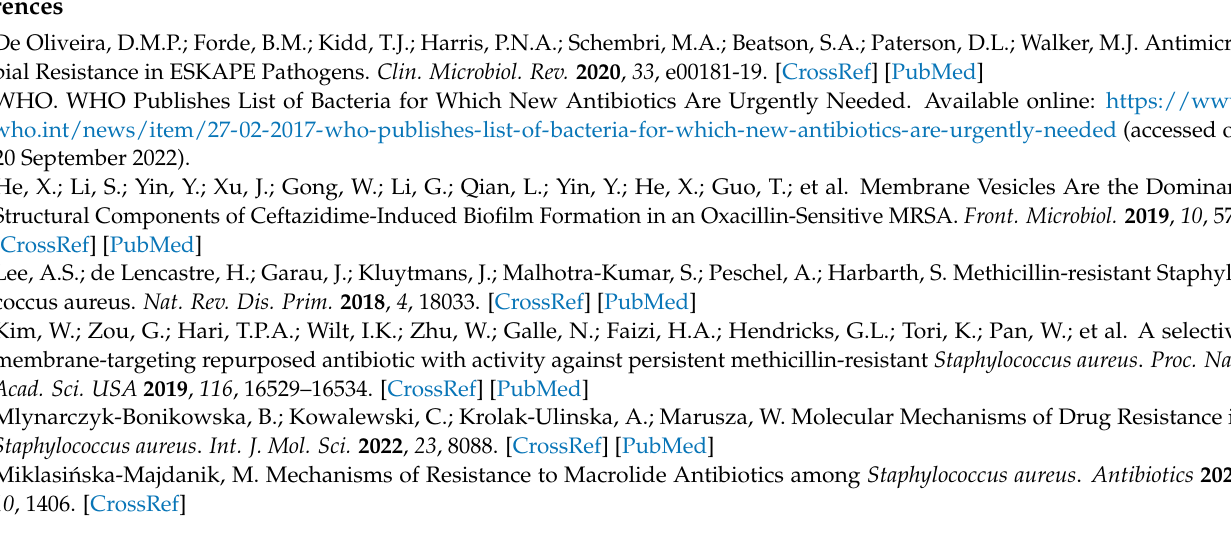
Figure S5: MRSA antibiogram, Figure S6: MSSA antibiogram, Figure S7: β —LPSA antibiogram, Figure S8: QRSA antibiogram, Figure S9: VRSA antibiogram, Figure S10: MLSB antibiogram, Figure S11: M15RL antimicrobial stability to different pH